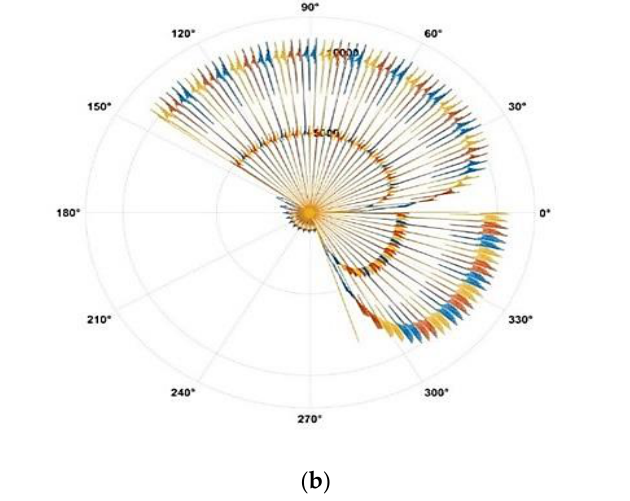
Figure 16. ( a ) Polar representation of extracted features of HIF fault ( b ) Polar representation of extracted features of CCHIF fault.